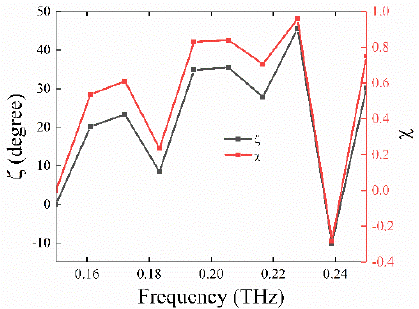
Figure 10. Simulated degree of circular polarization (χ) and ellipticity angle (ζ) for the incident y -polarized light in the range of 0.15–0.25 THz.